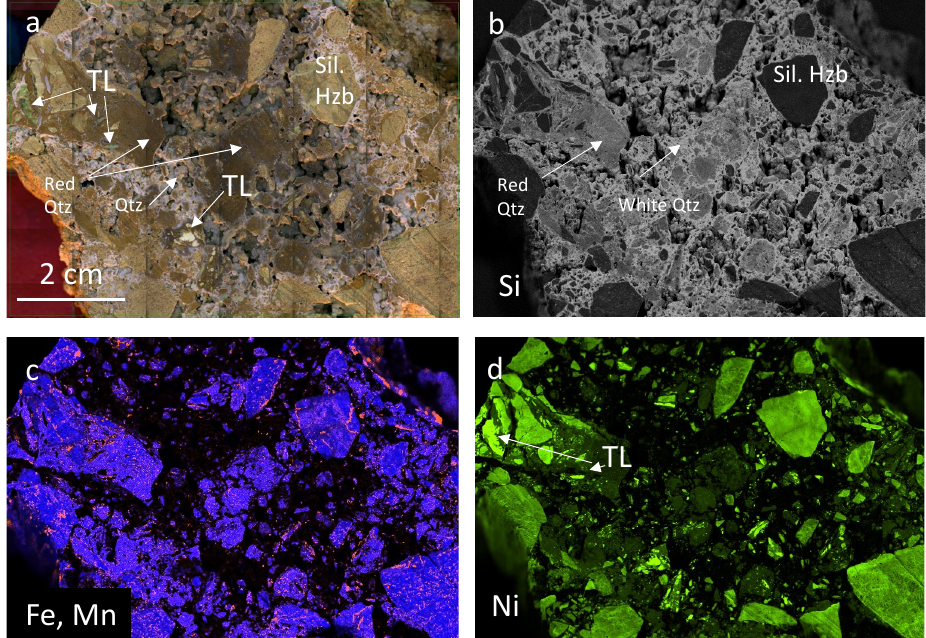
Figure 5. Micro-XRF images: ( a ) Silicified breccia sample from Cagou pit (Koniambo) with clasts of silicified harzburgite (Sil. Hzb), red-brown microcrystalline quartz (Red Qtz) and Ni-rich talc-like ore (TL). ( b ) Si map. ( c ) Superimposed Fe and Mn maps: Mn as Mn oxyhydroxides is located in microfractures and microvugs; Fe is present mainly in silicified harzburgite and red-brown microcrystalline quartz. ( d ) Ni map showing the location of mineralised clasts of ore Type 1 and clast of silicified harzburgite particularly enriched in Ni (TL: Ni-rich talc-like). All chemical images ( b – d ) are at the same scale than the macrophotograph shown in ( a